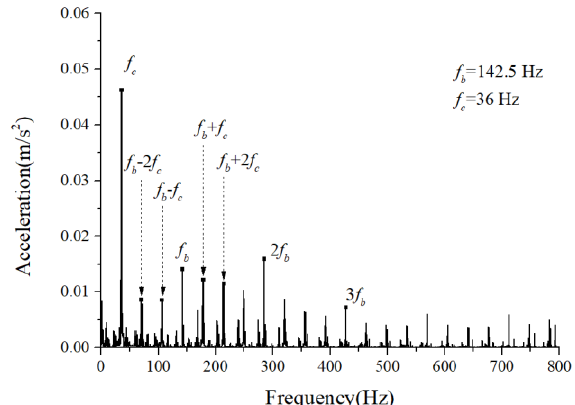
Figure 29. Acceleration waveform.